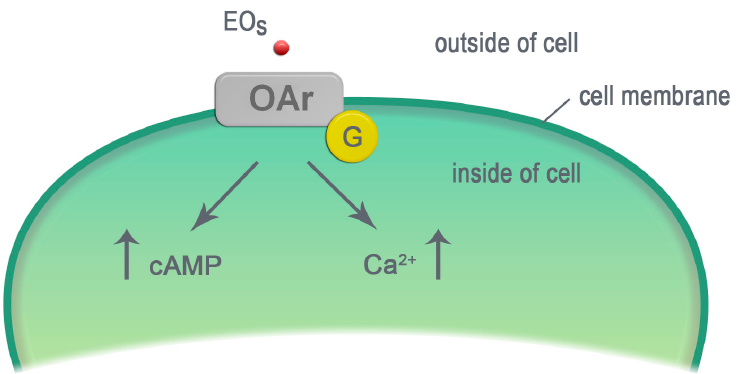
Figure 3. The EO components activate the octopamine receptors. EOs—essential oil components, OAr—octopamine receptor, G—protein G, cAMP—cyclic adenosine monophosphate, Ca 2+ —calcium ions, ↑ —increase in the molecule level.